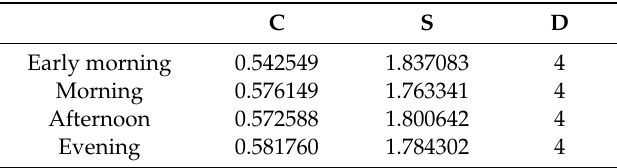
Table 5. The average cluster coe ffi cient (C), average path length (S), and diameter (D) of SINB on weekends.